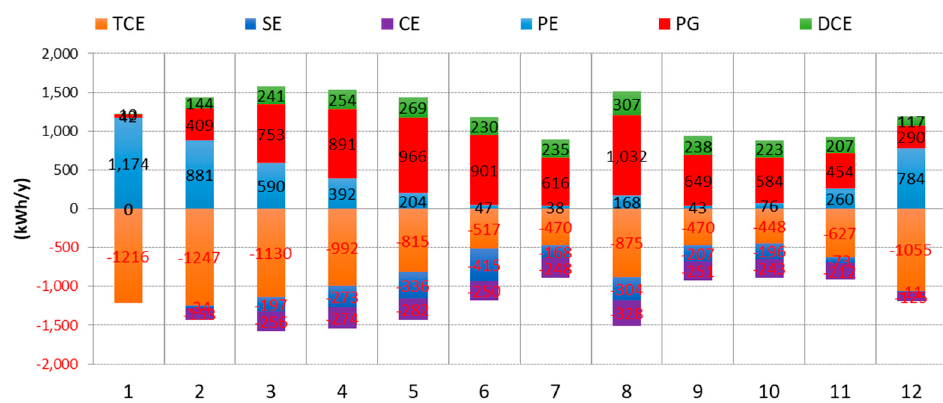
Figure 9. Monthly energy balance for PV8 SB (M).